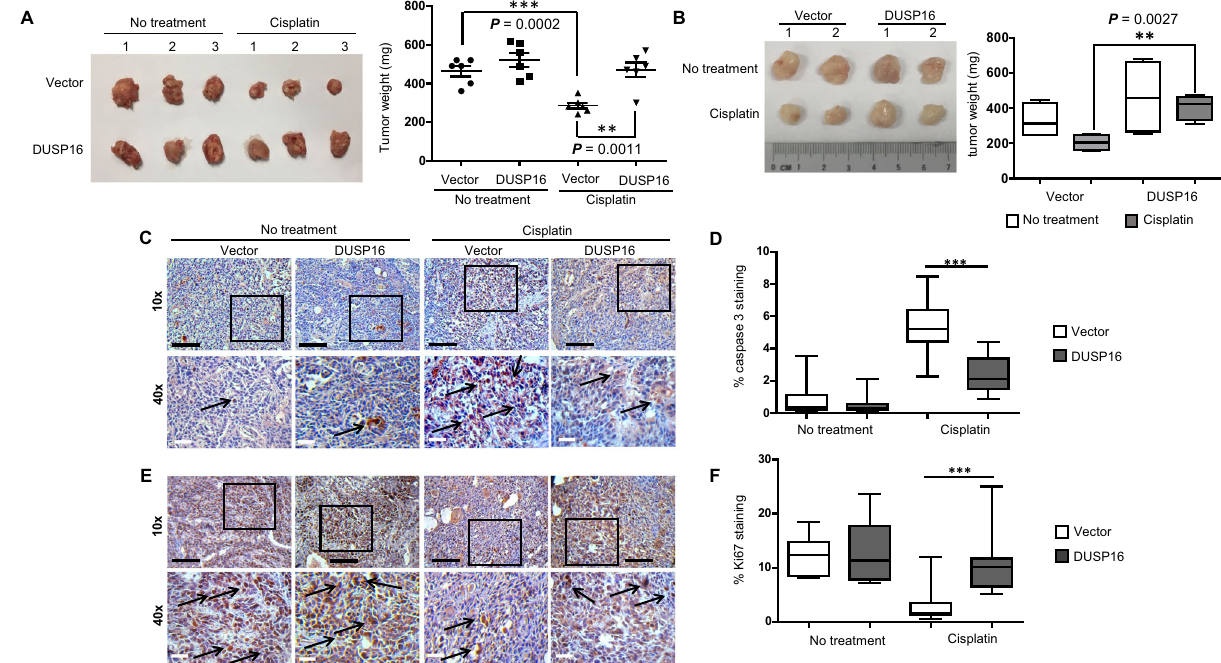
Fig. 5 Overexpression of DUSP16 resulted in increased resistance of cancer cells to cisplatin treatment in vivo. A Vector- or DUSP16 -transfected HK-1 cells were inoculated into NSG mice. Cisplatin was injected at 3 mg/kg body weight every 3 days. After 20 days, tumors were harvested to measure the sizes and weights. The data are expressed as dots representing the weight of each tumor; the scale bars are the mean ± standard error of the mean (SEM) of tumor weights from six mice in each treatment group of the representative experiment (mean ± SEM, n = 6). Statistical analysis was performed using two-tailed unpaired t -test. B Growth of untreated and cisplatin-treated xenografts of vector- and DUSP16 -transfected DLD-1 cells. Box-and-whisker plots show means ± SEM of tumor weights from four mice from each treatment group per experiment (mean ± SEM, n = 4). Boxes correspond to the 25th, 50th/ median and 75th percentiles; whiskers denote maximum and minimum. Statistical analysis was performed using two-tailed unpaired t -test. C , D IHC analysis for cleaved caspase 3 of HK-1 tumor sections; representative images of cleaved caspase 3 staining ( n = 6) were shown ( C ). Boxed regions were magni fi ed and presented under the respective panels. Black arrows highlight the caspase 3 staining. Box-and-whisker plots show means ± SEM of the means of cleaved caspase 3 staining in each group of mice ( D ). Boxes correspond to the 25th, 50th/median and 75th percentiles; whiskers denote maximum and minimum. Statistical analysis was performed using two-tailed unpaired t -test. *** P < 0.0001 (mean ± SEM, n = 3). E , F IHC analysis for Ki67 of tumor sections. Representative images of Ki67 staining were shown ( E ). Boxed regions were magni fi ed and presented under the respective panels. Black arrows highlighted the Ki67 staining. Box-and-whisker plots show means ± SEM of Ki67 staining ( F ) from each group of mice *** P < 0.0001 (mean ± SEM, n = 3). The data are representative of three experiments with similar results. Source data are provided as a Source data fi